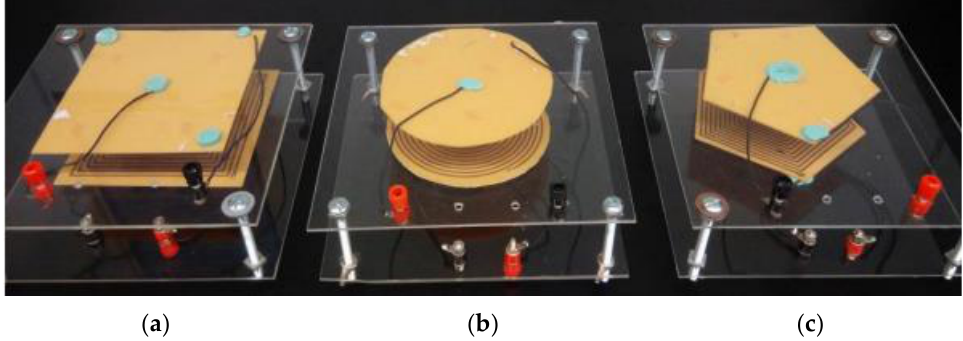
Figure 6. Circuits for wireless power transmission containing the transmitting and receiving coils in ( a ) square, ( b ) oval, and ( c ) pentagonal shapes.